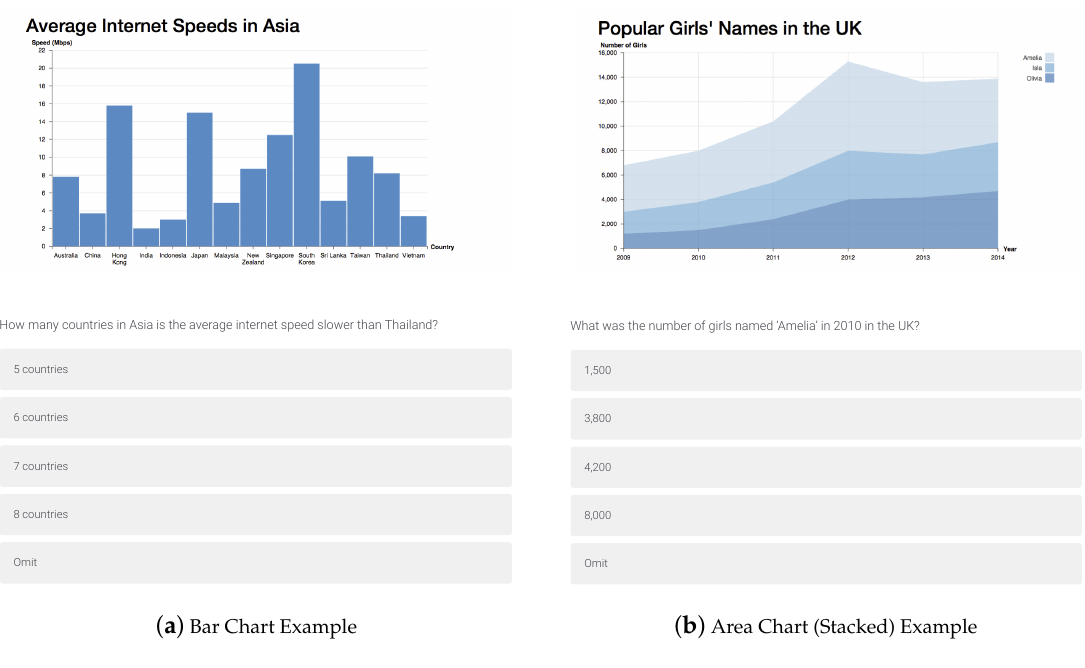
Figure 1. Screenshots for Visualization Literacy Assessment Test